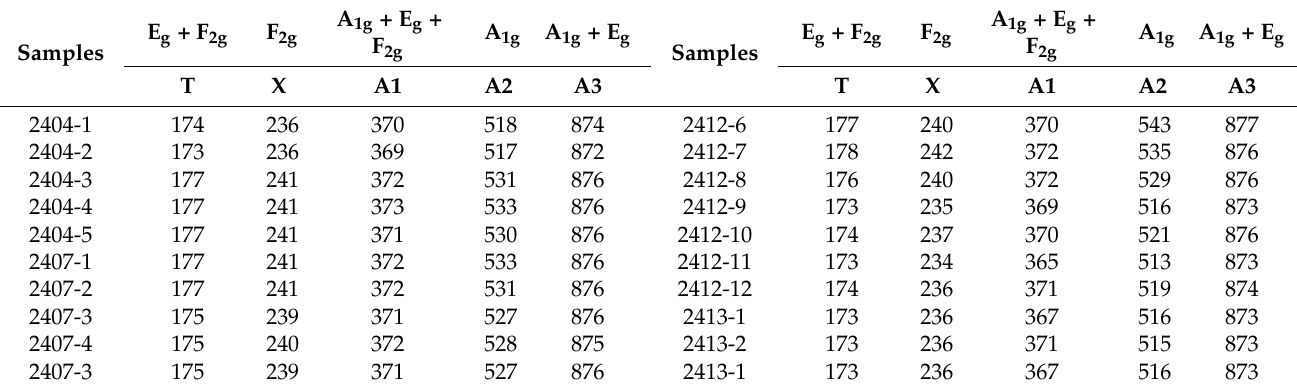
Table 2. Raman peaks (cm − 1 ) of